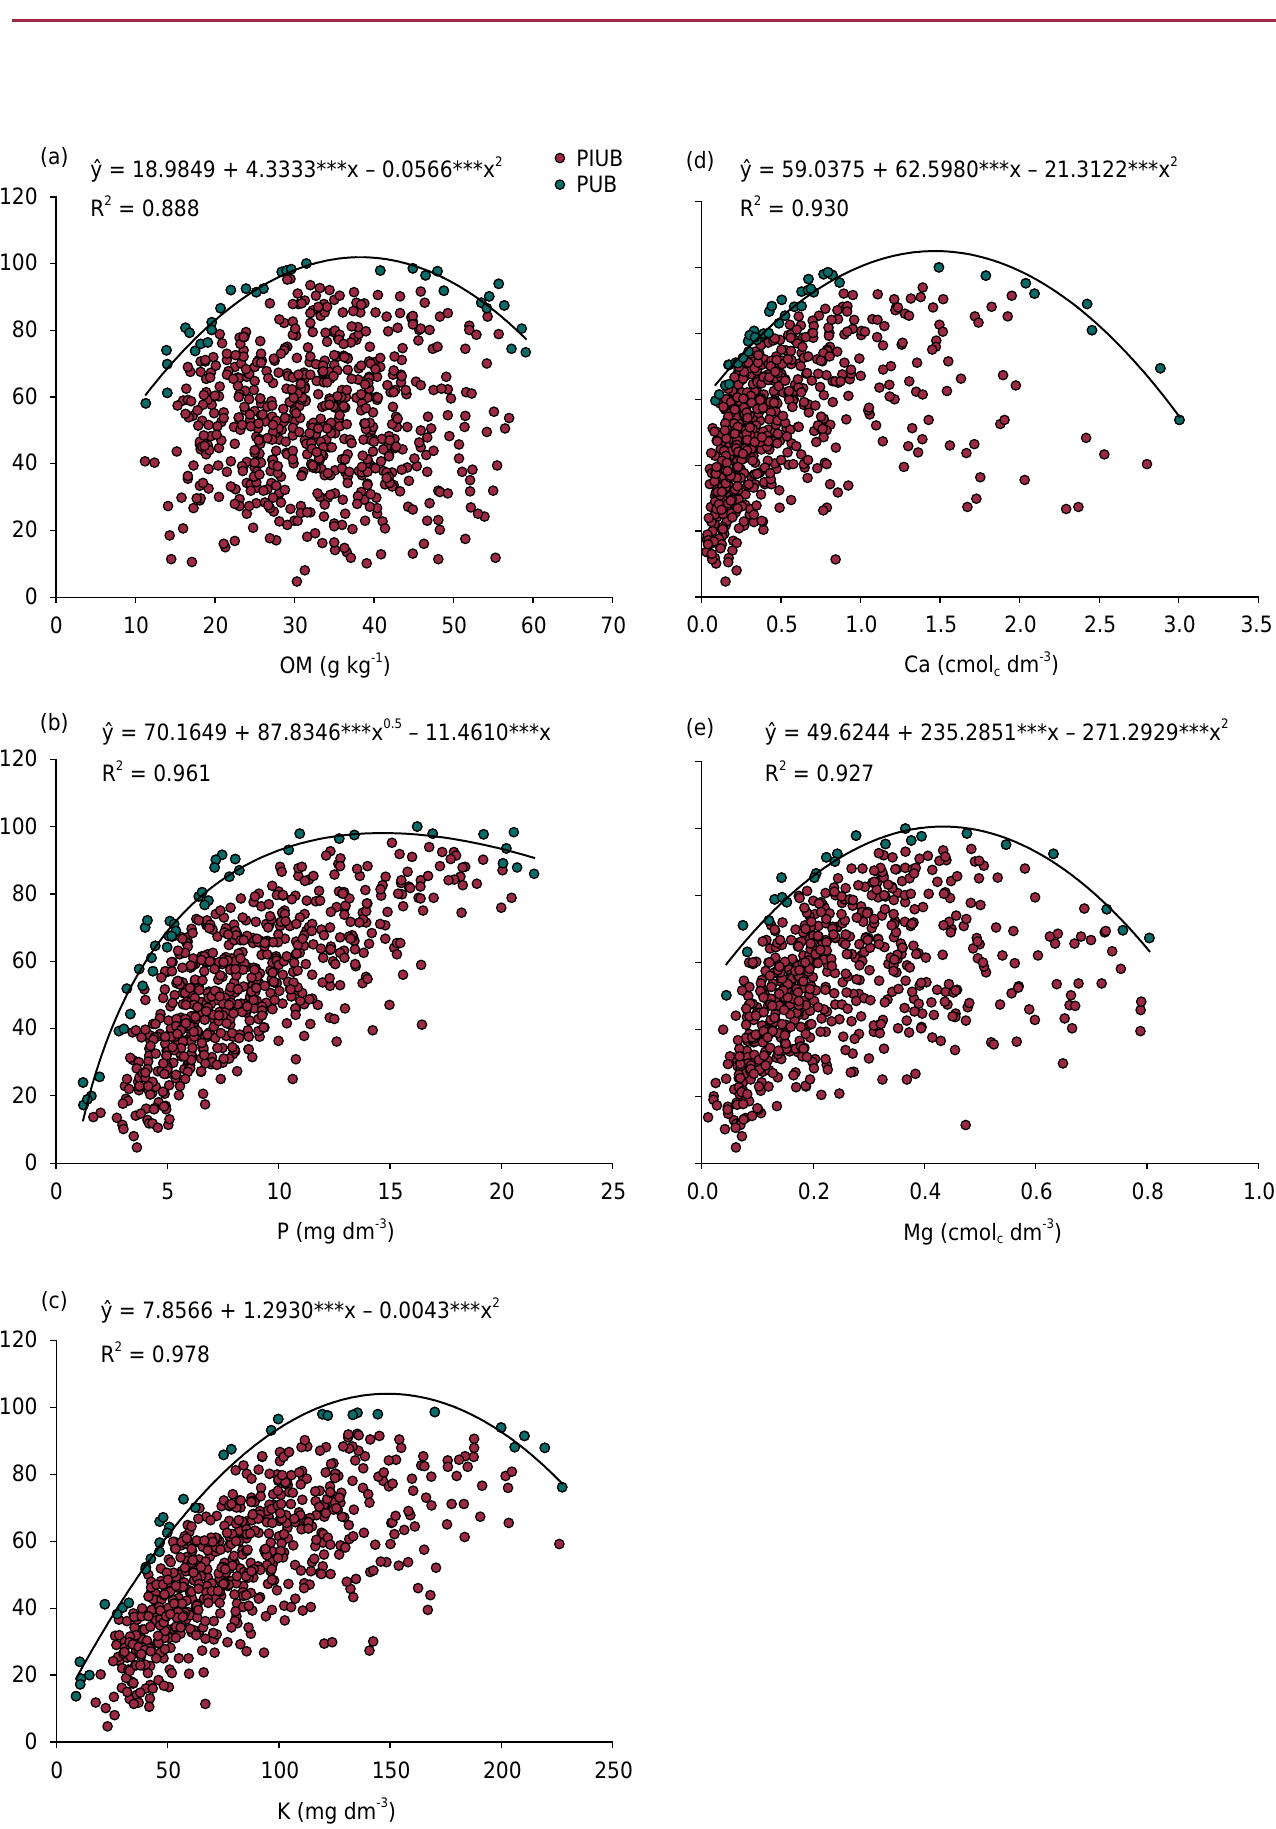
Figure 3. Scatter diagram and the boundary line of the relationship between the relative MAI of eucalyptus and OM (a), available P (b), available K + (c), exchangeable Ca 2+ (d), and exchangeable Mg 2+ (e) content in the soil (0.00-0.20 m). PIUB: points lower than the upper boundary; PUB: points of the upper